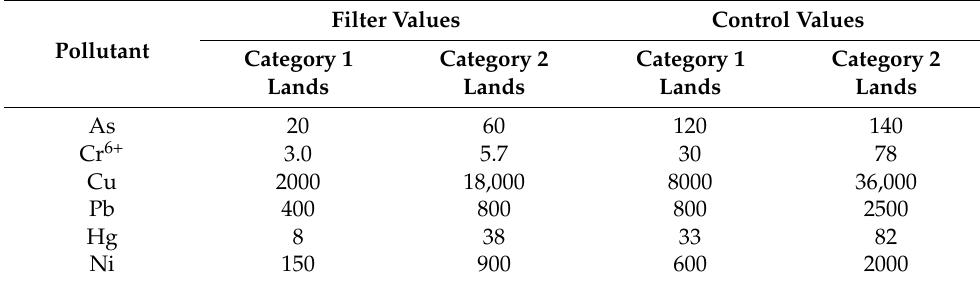
Table 4. Filter and control values of the PTE pollution risk for development lands